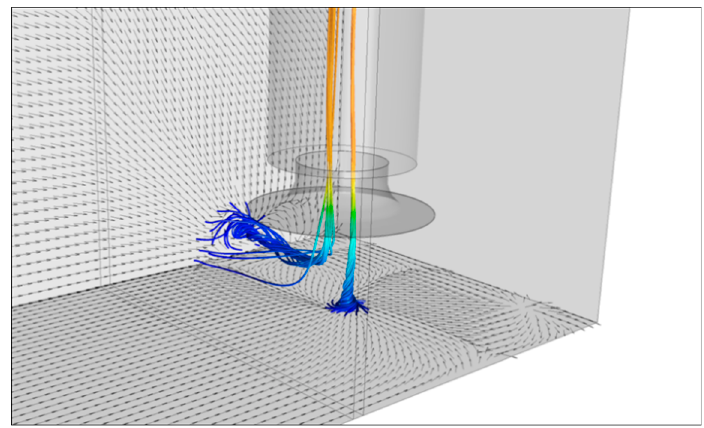
Figure 16. Floor vortex and sidewall vortex.